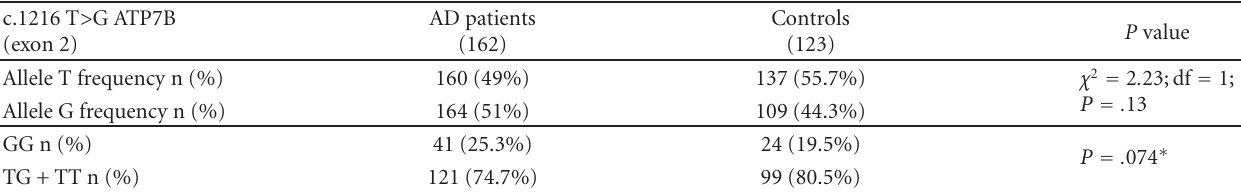
Table 3: c.1216 T > G ATP7B (exon 2) SNP allele distribution in AD patients and healthy controls and comparison of GG versus TG + TT.